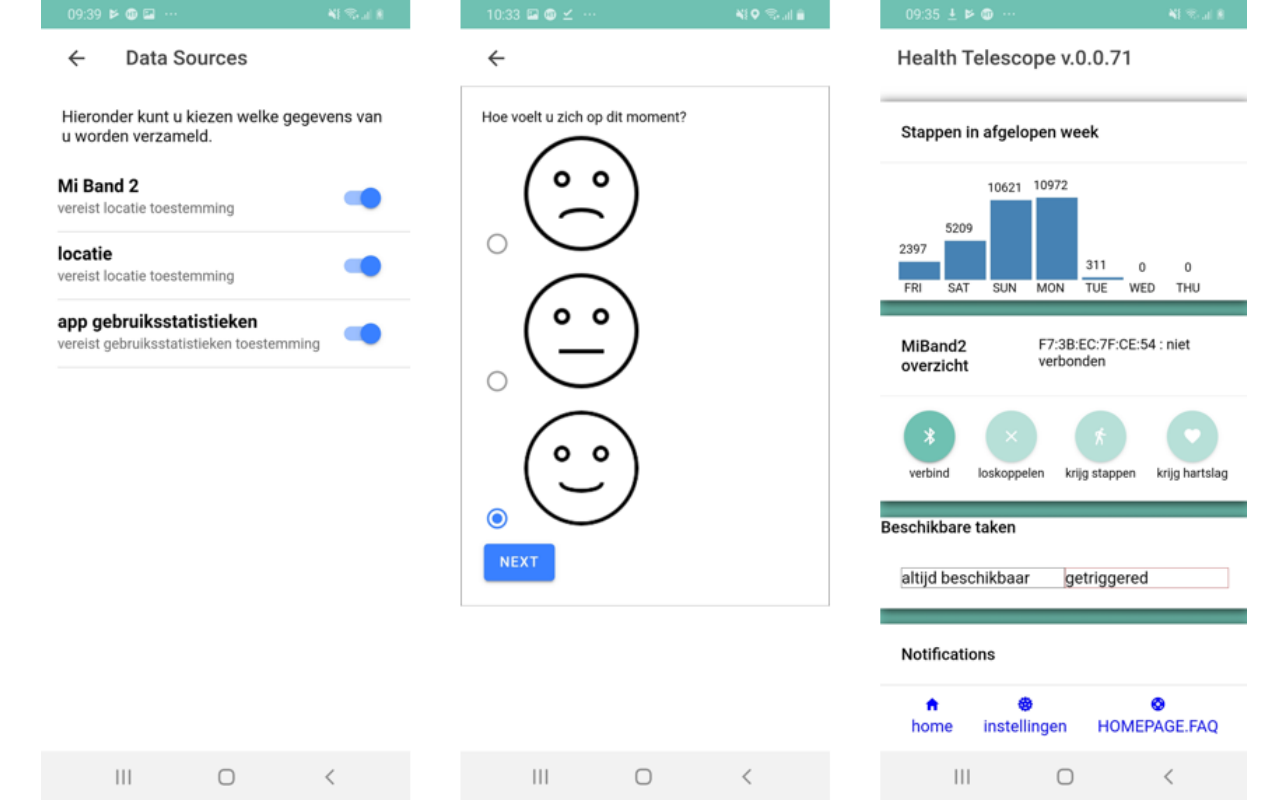
Figure 3. Screenshots of the Health Telescope